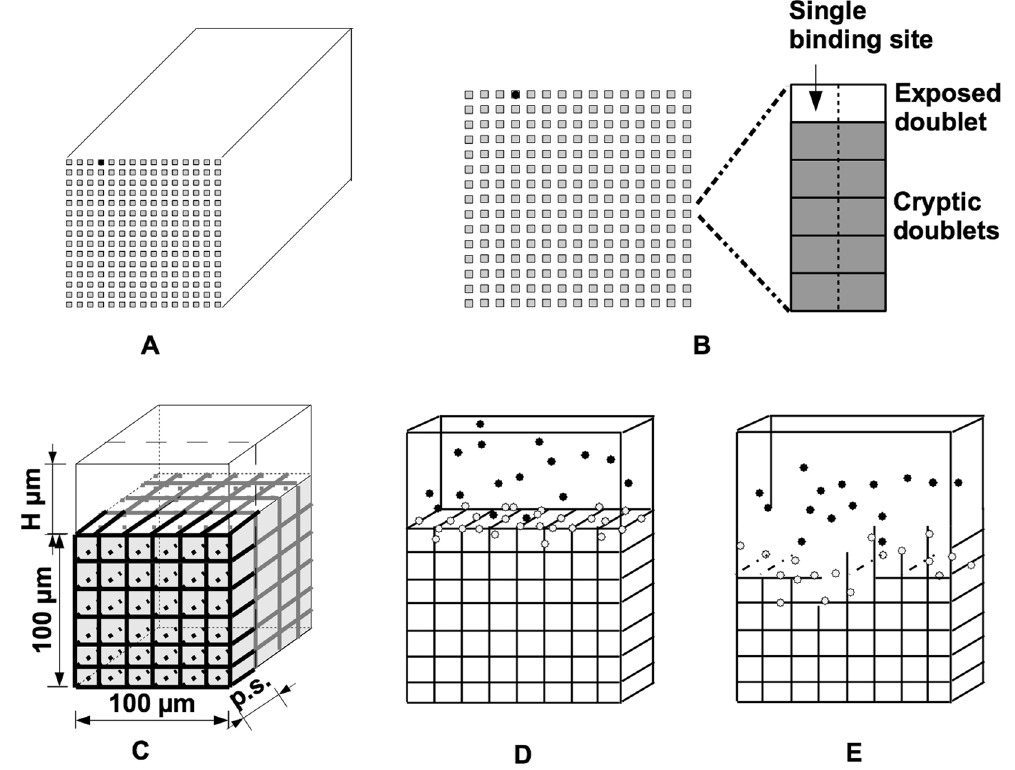
Figure 1. Schematic diagram of multiscale model. ( A ) The microscale model is a cross section (the square grid of gray squares) of the fibrin fiber. For simplicity, we approximate the circular cross section of the cylindrical fiber by a square of equal area. The microscale model is initialized with a single tPA molecule (black dot) randomly placed on the outer edge of the fiber. ( B ) On the left is the fiber cross section. Each gray square in the cross section represents 6 binding doublets (as seen on the right). A binding doublet is a pair of binding sites to which tPA, plasminogen, and plasmin can bind. Initially, there is one exposed binding doublet at each location, and 5 cryptic doublets that can be exposed by plasmin during degradation. A tPA molecule on a binding doublet may convert plasminogen on any doublet at the same binding location to plasmin. ( C ) The macroscale model represents a 3-D fibrin clot formed in a small chamber. The black and gray lines comprising the lattice represent the fibrin fibers. The size of the chamber is 100 × 100 × (100 + H ) μ m 3 . For simplicity, we only consider one periodic slab of clot, one fiber thick (black). “p.s.” means “pore size”, the distance between fibers. ( D ) The macroscale model is initialized by randomly placing a fixed number of tPA molecules at the top of the chamber. The tPA molecules (black and white dots) can diffuse and bind to fibrin fibers (black). Unbound tPA is shown in black, bound tPA is shown in white. ( E ) When tPA binds to a fiber, it initiates the lytic process, so that some time after tPA has bound to a fiber, the fiber